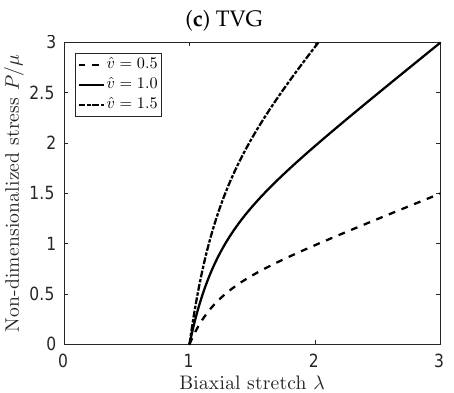
Figure 3. Effect of Isotropic Volume Growth (IVG), in-Plane Volume Growth (PVG), and in-Thickness Volume Growth (TVG) kinematics on the stress-stretch properties of the neo-Hookean material under equi-biaxial extension. First Piola-Kirchoff Stress ( P ) versus stretch ( λ ) is depicted for constant ˆ v = 1.0 (solid curves), decreasing ˆ v = 0.5 (dashed curves), and increasing ˆ v = 1.5 (dash-dotted curves) tissue